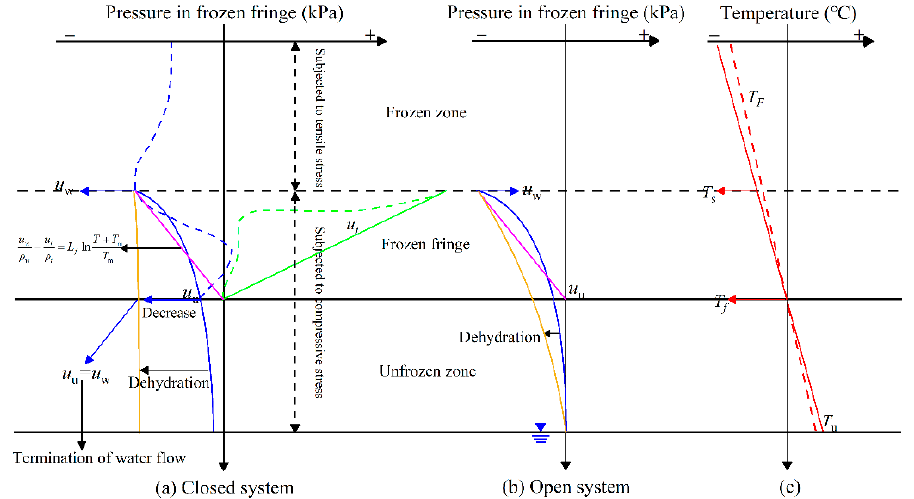
Figure 1. Schematic diagram of the frost heave model. ( a ) Open system, ( b ) Closed system, ( c ) Temperature distribution in closed system and open system. The solid lines represent the quasi-static state, and the dashed lines represent the dynamic state. The blue lines represent the pore water pressure, the pink line represents the pore water pressure expressed by the Clapeyron Equation, the brown line represents the pore water pressure in the case of terminated water flow, the green lines represent the pore ice pressure, and the red lines represent the soil temperature.